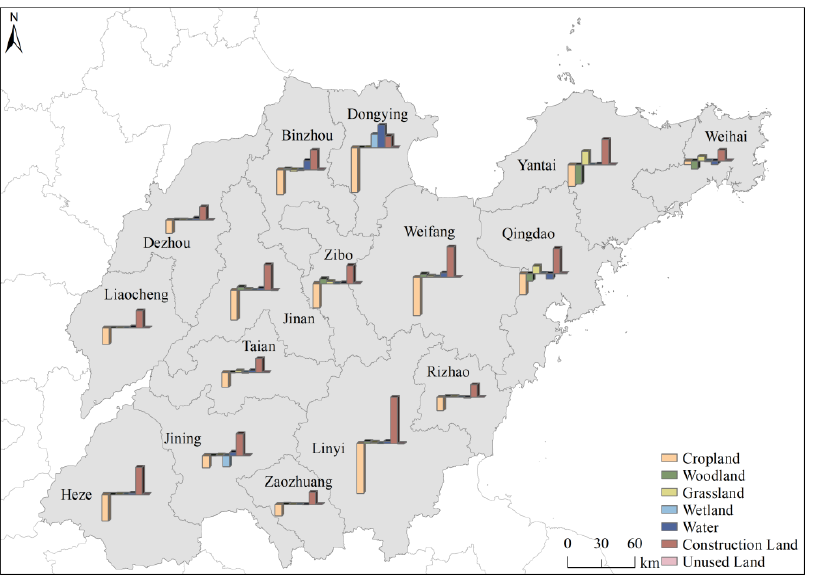
Figure 3. Area variation in land use type area in 16 cities of Shandong Peninsula urban agglomeration during 2000–2019 (unit: km 2